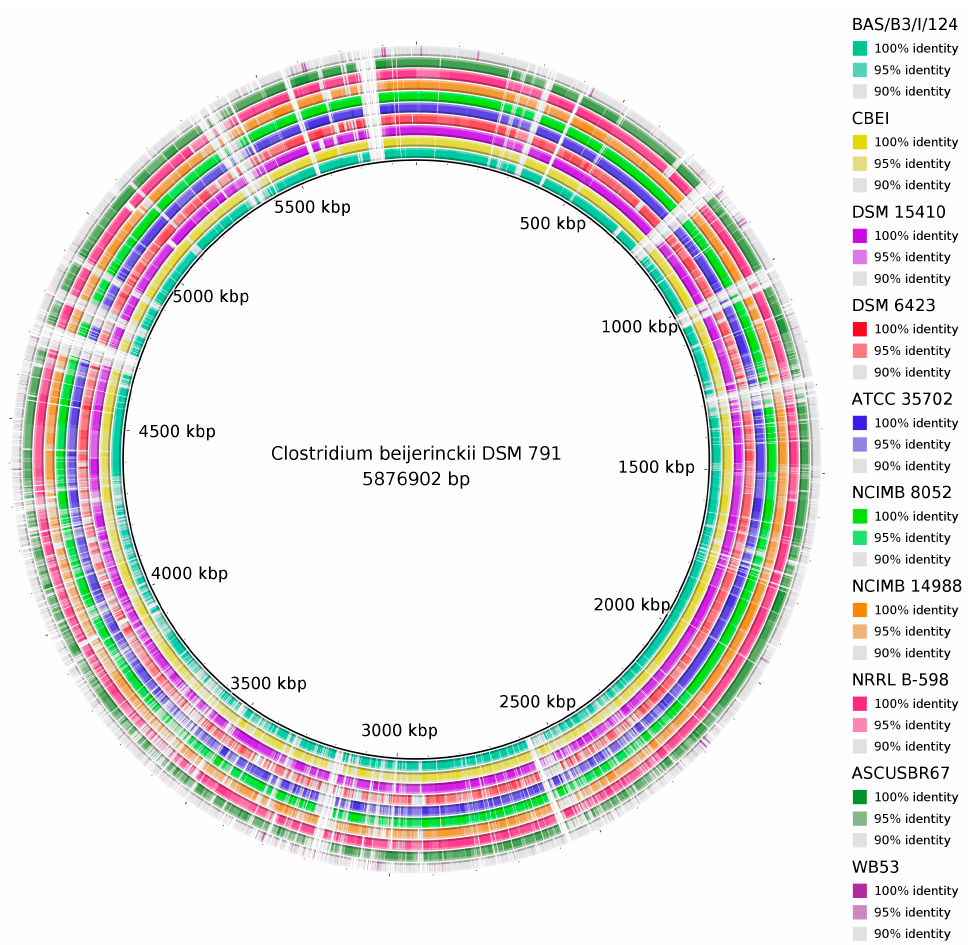
Figure 2. Whole-genome comparison of the type strain C. beijerinckii DSM 791 T to other C. beijerinckii complete genomes with the visualization of genomes percentage identity.